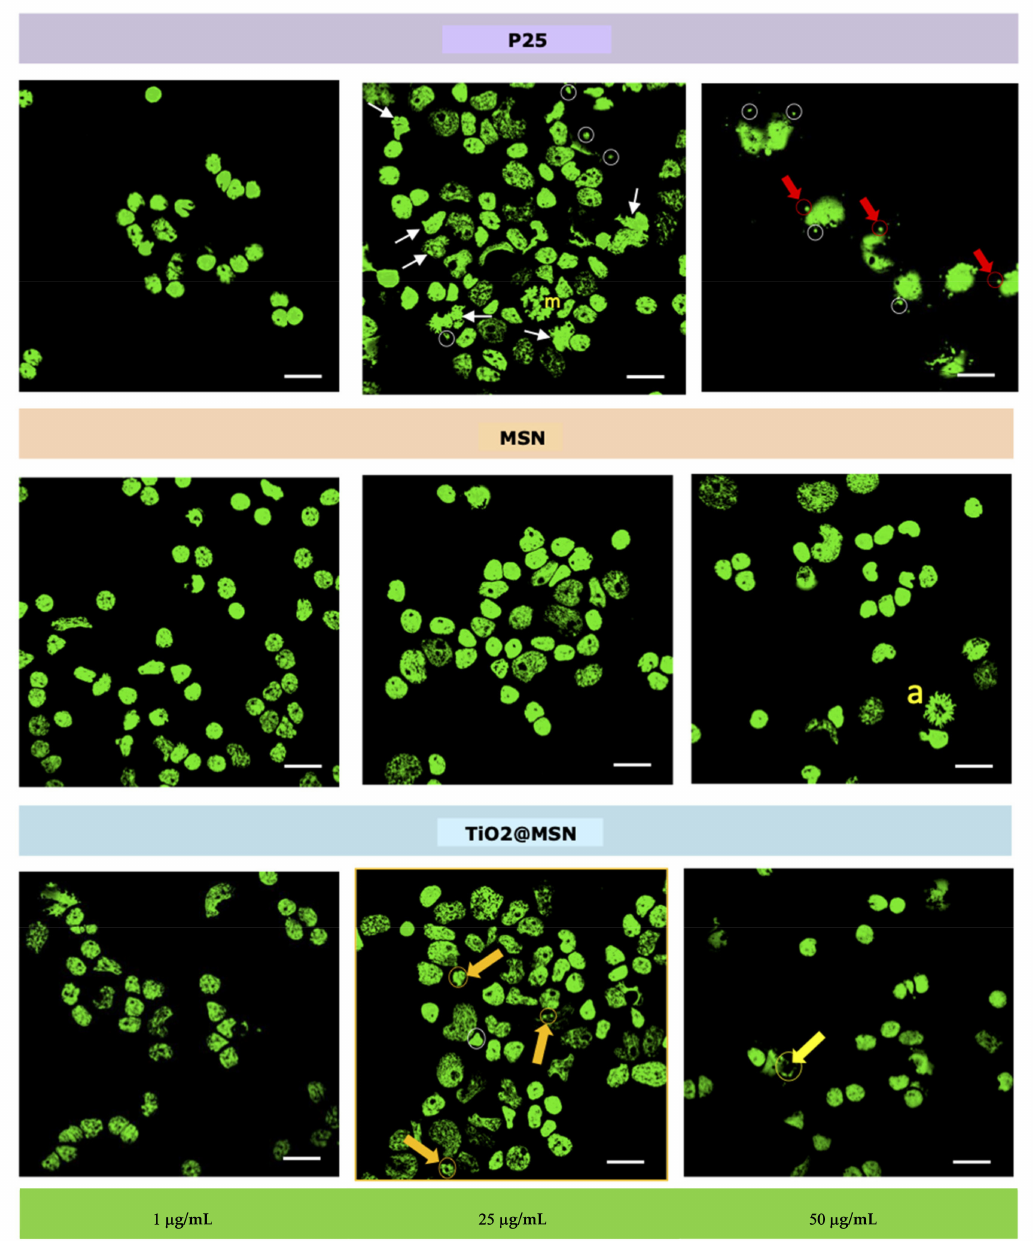
Figure 7. Nuclear morphology. Bright micronuclei (MN, circles), nuclear anomalies (white arrows). Nuclear buds (NBUDs, red arrows) and chromatin bridges (yellow arrow). Dividing nuclei were observed (m = metaphase; a =